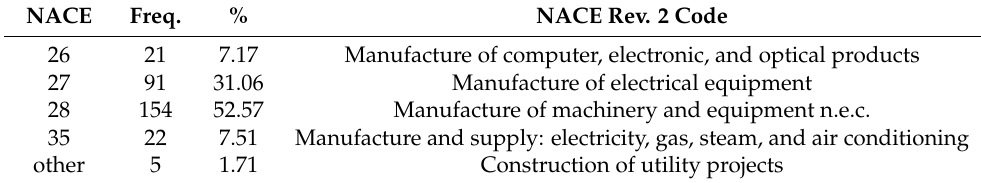
Table 2. Sample by NACE Rev. 2